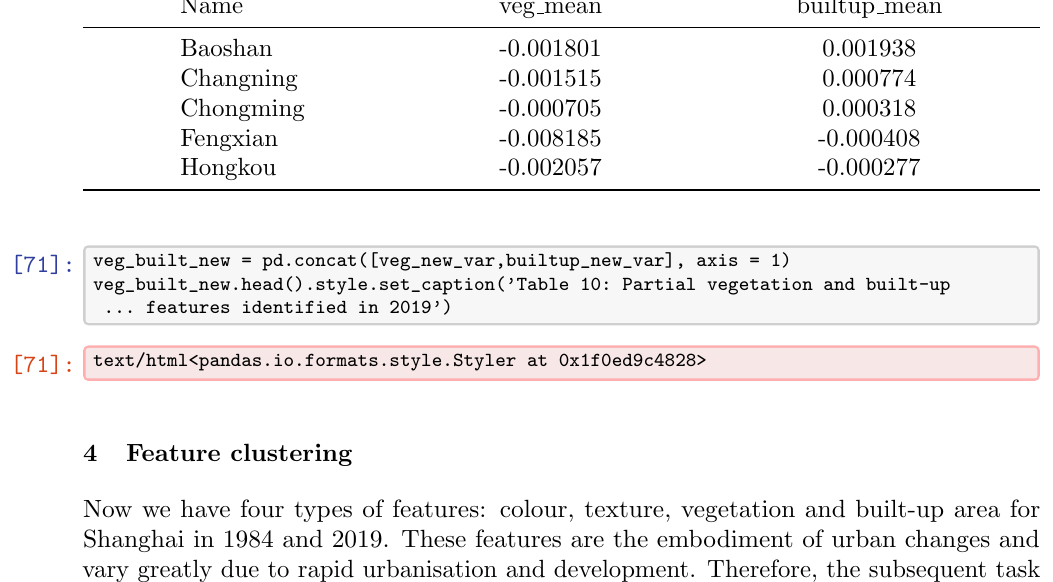
Table 10: Partial vegetation and built-up features identified in 2019